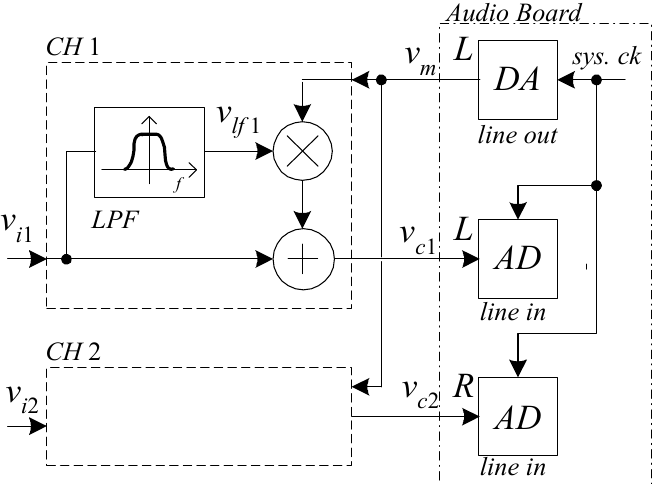
Figure 1. Block diagram illustrating the principle of operation of the proposed approach. The block indicated with CH 2 is identical to the block CH 1. The signals v i 1 and v i 2 come from the outputs of the low noise preamplifiers that are part of the low noise measurement set up. The system can be used in single or dual channel mode, or to estimate the cross spectrum between the inputs.